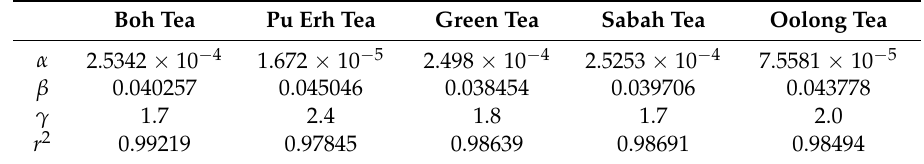
Table 1. Parameter Values of Equation